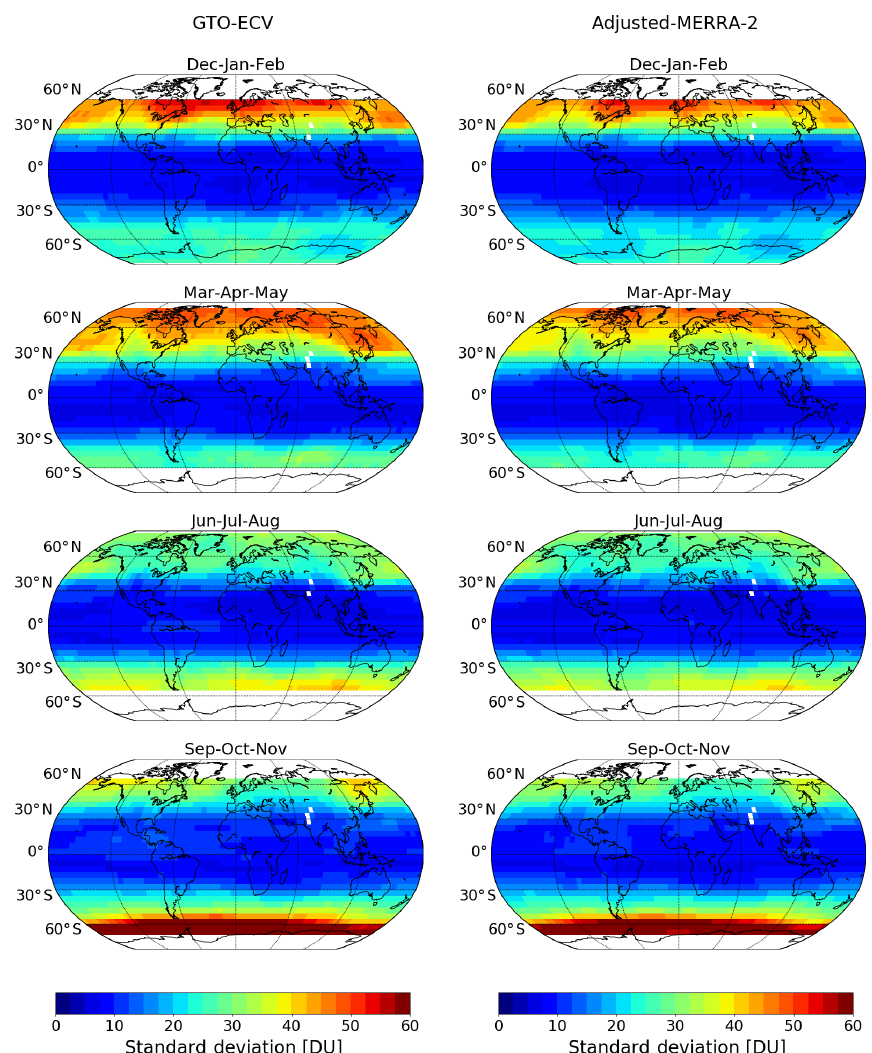
Figure 5. Seasonal mean standard deviations for GTO-ECV (left column) and adjusted MERRA-2 (right column). From top to bottom: